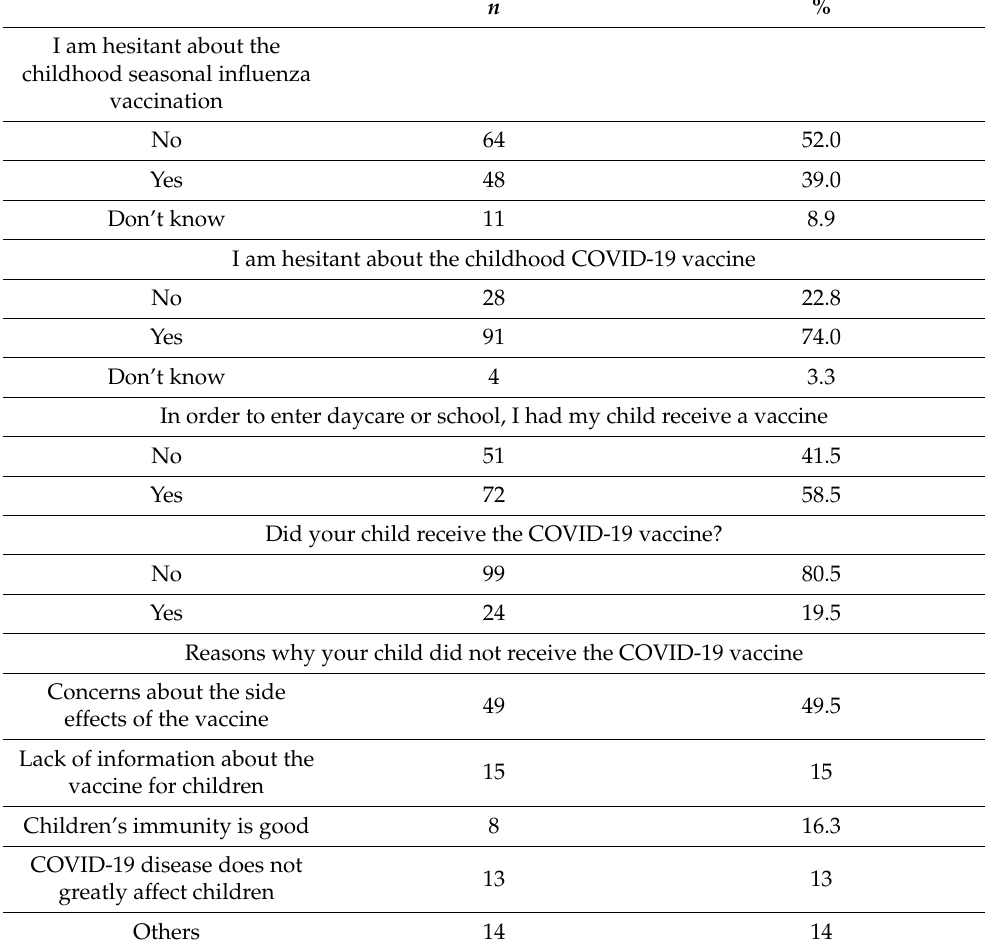
Table 2. Hesitancy toward COVID-19